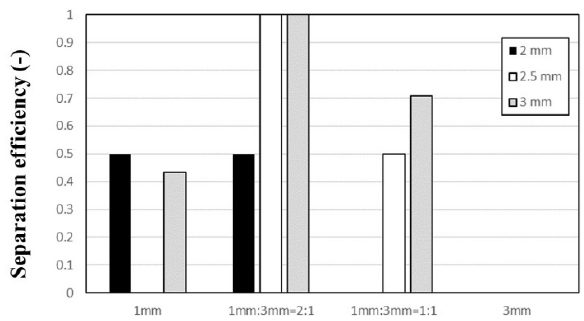
Figure 10. Separation efficiencies of Al and STS scraps at 4 min by vibrating with vibration amplitudes of 2, 2.5, and 3 mm using a ball bed with various ratio of 1-mm and 3-mm balls.